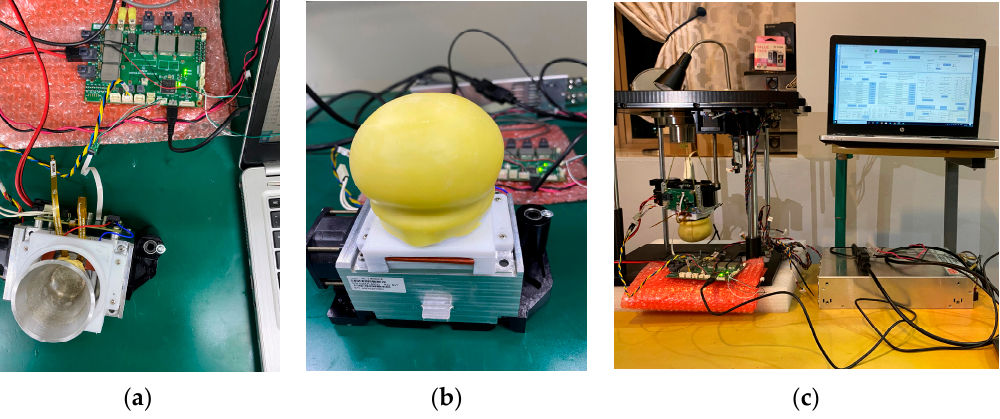
Figure 11. Prototype: ( a ) spreader; ( b ) membrane assembled over spreader; ( c ) test set up.